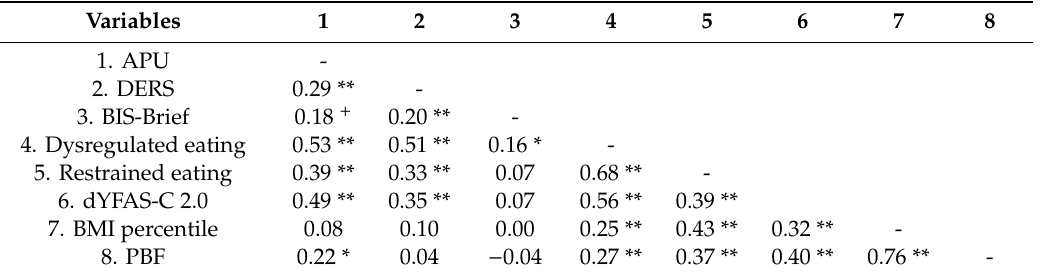
Table 2. Associations of Addictive Phone Use (APU) with Emotion Regulation Di ffi culties (DERS), Impulsivity (BIS-Brief), Eating Behaviors, Food Addiction (dYFAS-C 2.0), Body mass index (BMI) Percentile, and Percent Body Fat (PBF).